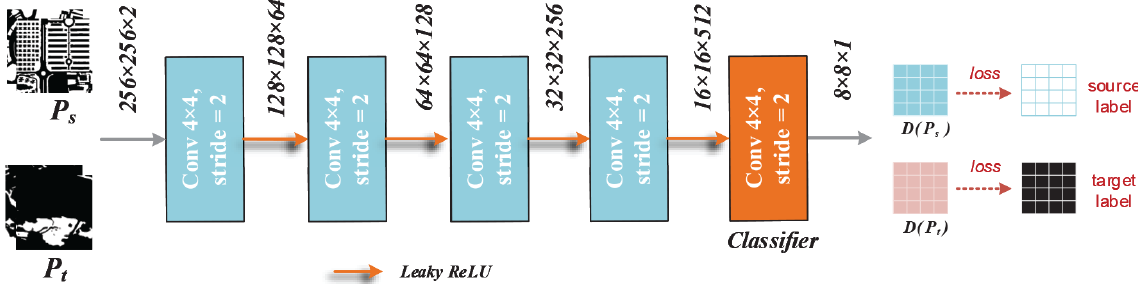
Figure 8. The structure of the